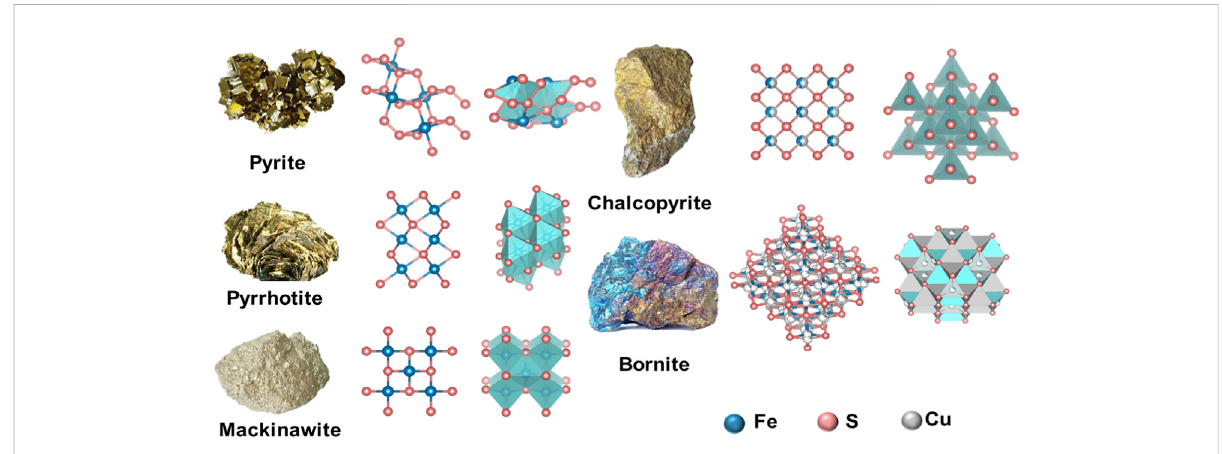
FIGURE 1 The crystal structure of ISNs from natural minerals. Reproduced with permission from Ref. (Lai et al., 2021). Copyright 2021 Elsevier B.V.